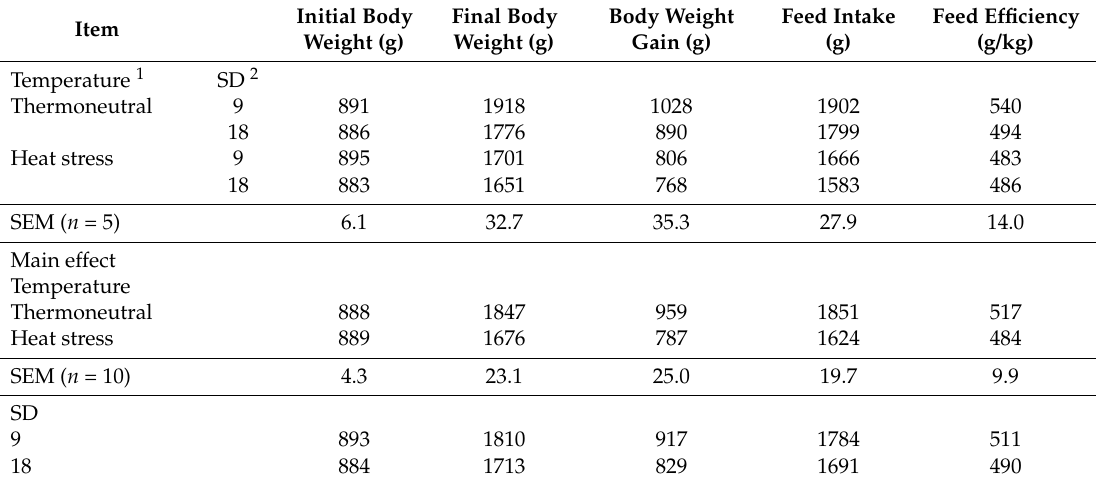
Table 2. Effect of heat stress and stocking density on the growth performance of growing broiler chickens from 21 to 35 days of